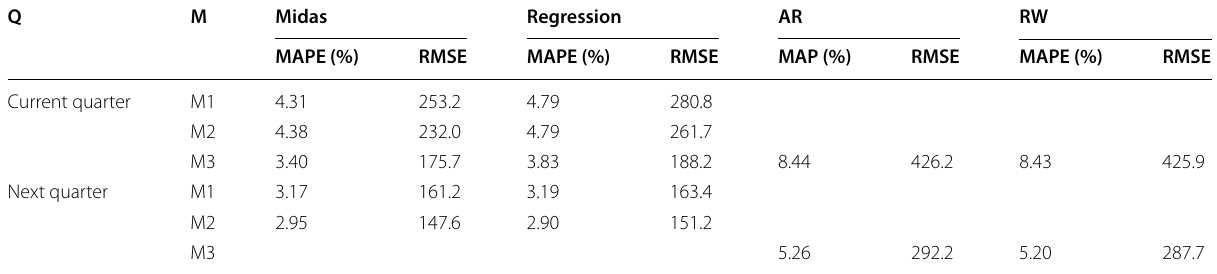
Table 12 MAPE and RMSE loss functions for the import of services models (in nominal values) Q